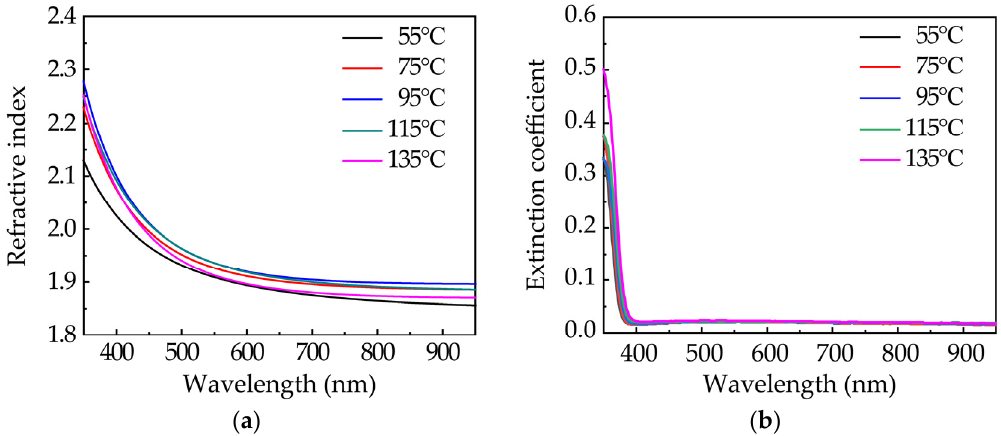
Figure 4. The wavelength-dependent ( a ) refractive indexes and ( b ) extinction coefficients of sALD-ZnO films deposited at various substrate temperatures.